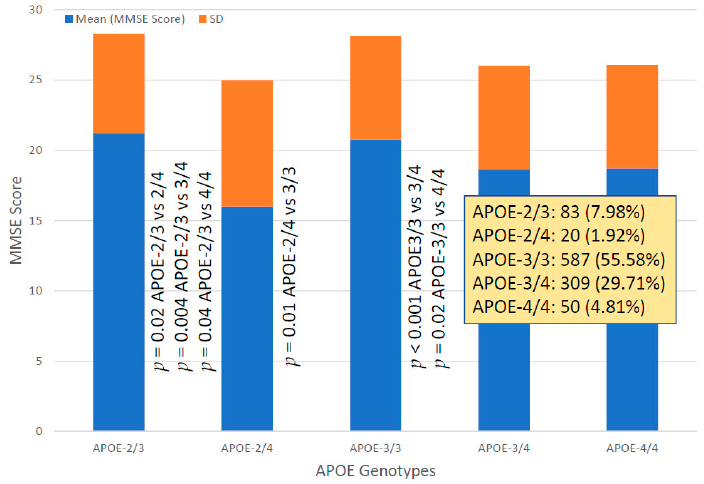
Figure 12. APOE -related mental performance (MMSE score) at diagnosis in Alzheimer’s disease.